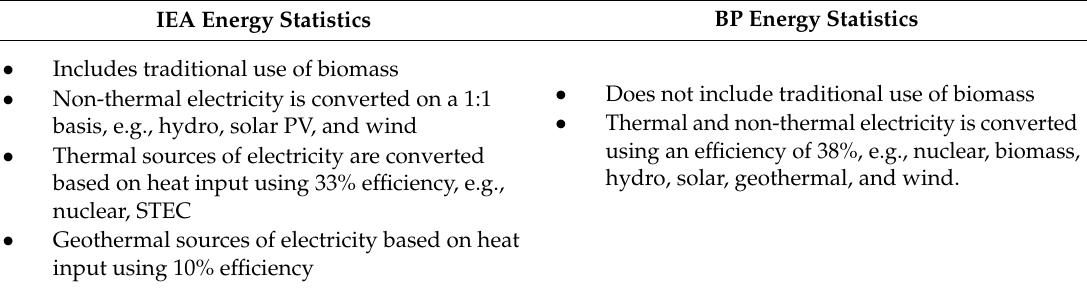
Table 1. Major di ff erences between methods used by the International Energy Agency (IEA) and BP to calculate primary energy